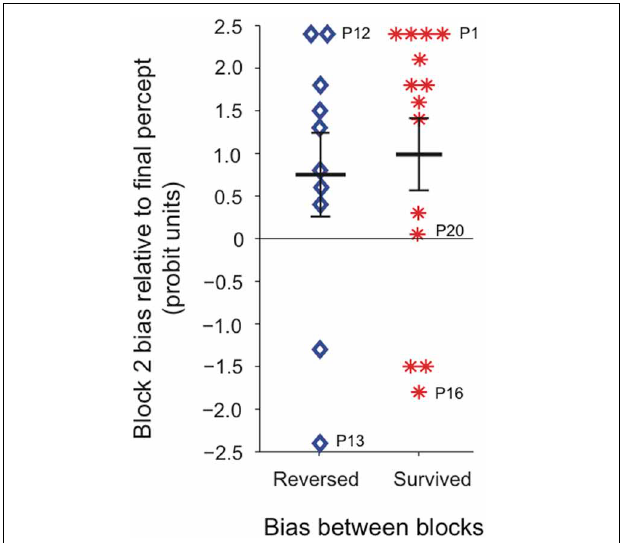
FIGURE 7 | Perceptual bias at the continuous location during block 2, for all participants tested ( N = 24). Participants were divided into two groups depending on whether the percept that dominated at the continuous location during block 2 was the same as (red asterisks), or opposite to (blue diamonds), the percept that had dominated at that location during block 1. Labeled data points indicate the corresponding individual observers’ data. Time courses for all individual observers are shown in Figure S3 . For the majority of observers the last percept experienced during continuous viewing correctly predicted subsequent perceptual bias at the continuous